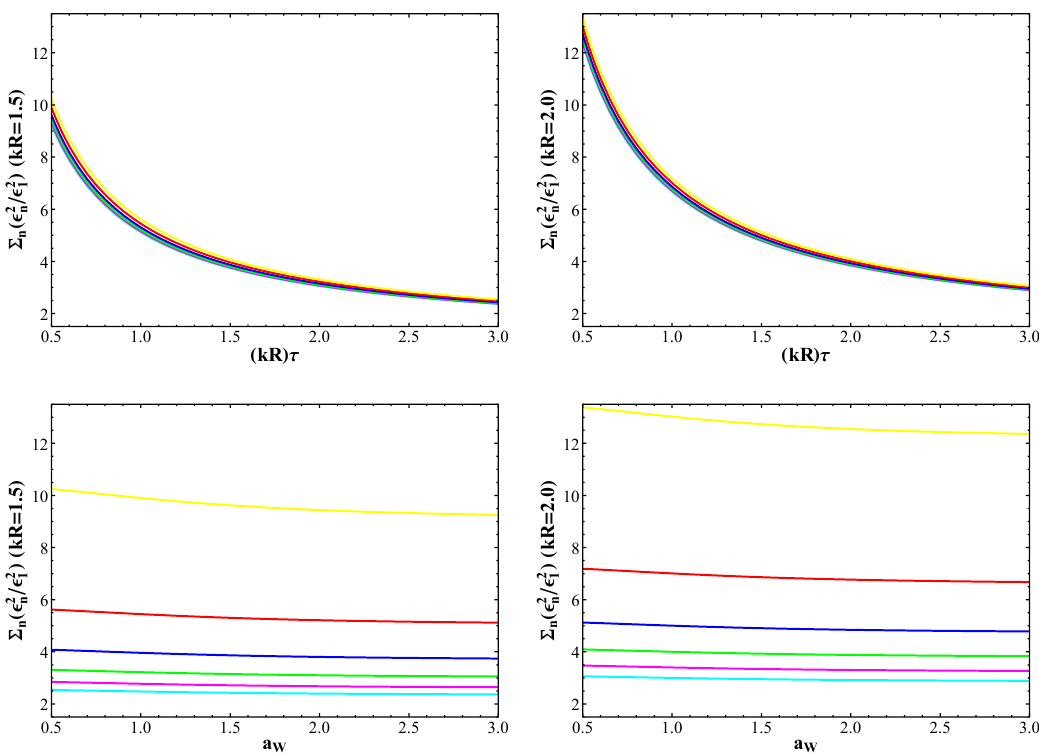
Figure 16 . (Top left) The value of the sum P of ( kR ) τ for a W = 3 (cyan), 5/2 (magenta), 2 (green), 3/2 (blue), 1 (red), and 1/2 (yellow), respectively. (Top right) As in the top left, but now assuming kR = 2 . 0 . (Bottom left) As in the top left, but now as a function of a W assuming ( kR ) τ = 3 (cyan), 5/2 (magenta), 2 (green), 3/2 (blue), 1 (red), and 1/2 (yellow), respectively. (Bottom right) As in the bottom left, but assuming kR = 2 . 0